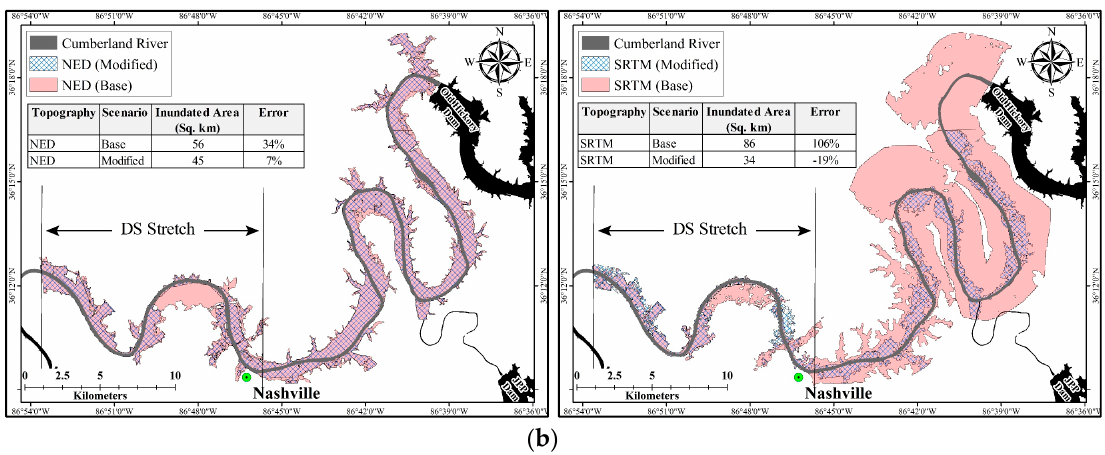
Figure 7. ( a ) Comparison of observed and simulated inundation extent for control scenario; ( b ) Comparison of observed and simulated inundation extent for test scenarios [NED ( left ), SRTM ( right )].